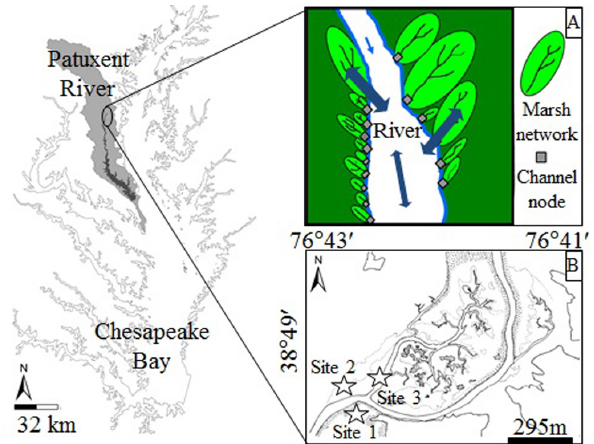
Fig. 1. Study area located in the tidal freshwater portion of the up- per Patuxent River, Maryland. (A) Schematic diagram showing the organization of tidal marshes along the river. Tidal fluxes are con- trolled by inlet channel geomorphology (governing node). (B) Map of selected marshes for mass balance measurements. Marsh areas (m 2 ) are as follows: Site 1: 670.6, Site 2: 5705, Site 3: